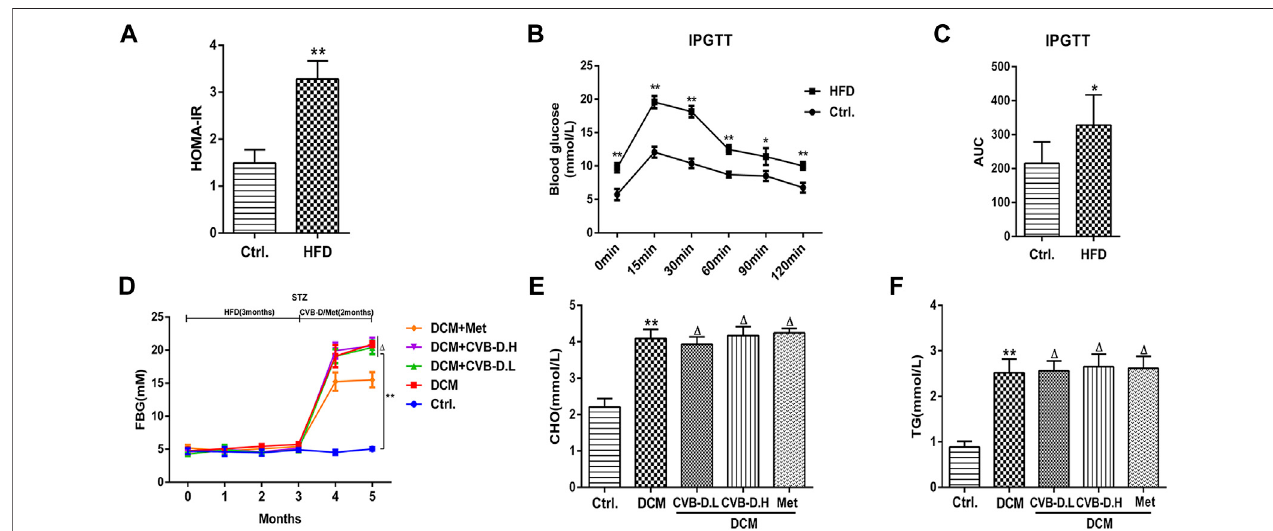
FIGURE 1 | HFD (high-fat and high-glucose diet) combined with STZ (streptozotocin) induces type 2 diabetes model in mice. (A) Insulin resistance index was calculatedinmicebydetectingFBG(fastingbloodglucose)andINS(insulin). (B) Afterintraperitonealinjectionofglucoseinfastingcondition,thebloodglucoseofmiceat different time points was measured. (C) Histogram of AUC (area under the curve) of blood glucose at different time points in mice. (D) FBG of mice during modeling and treatment. (E,F) EffectsofCVB-DonCHO(cholesterol)andTG(triglycerides)contentsinserumofDCM(diabeticcardiomyopathy)mice.Thedataarepresentedas the mean ± SEM ( n = 6), * p < 0.05, ** p < 0.01 versus the control group; Δ p > 0.05 versus the model